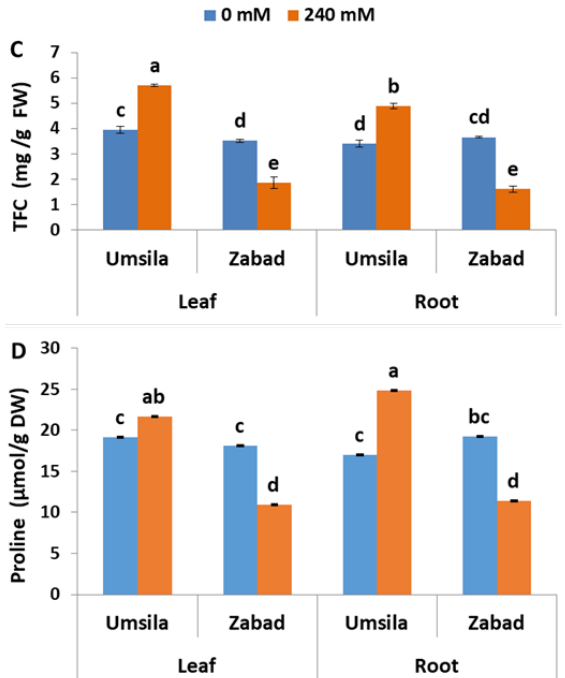
Figure 6. The effect of salinity on the concentrations of the non-enzymatic antioxidants total glutathione (GS) ( A ), total phenolic content (TPC) measured as mg gallic acid equivalent/g of fresh weight of the plant tissues ( B ), total flavonoid content (TFC) measured as mg catechin equivalent/g of fresh weight of the plant tissues ( C ) and proline ( D ) in date palm seedlings when subjected to control (0 mM NaCl) and salinity (240 mM NaCl) conditions. Bars represent the mean ± SE ( n = 3).